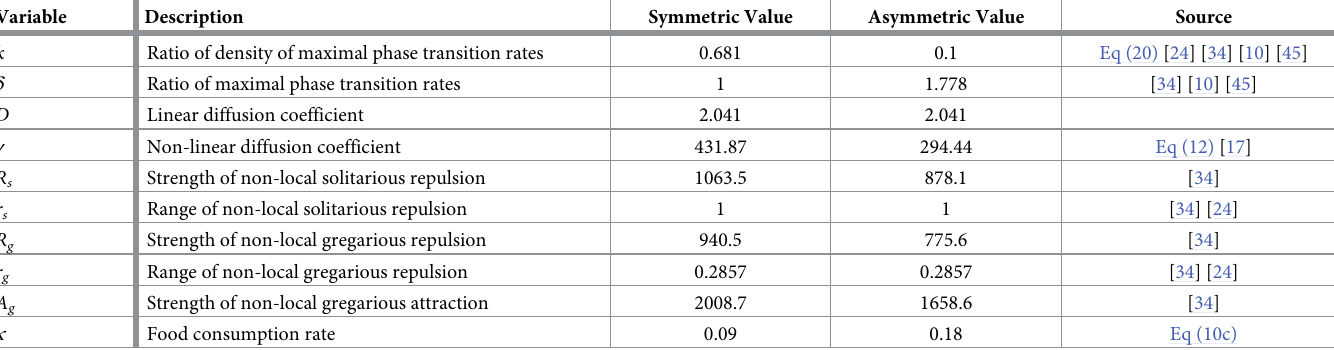
Table 1. Dimensionless parameters used in numerical simulations for both symmetric and asymmetric